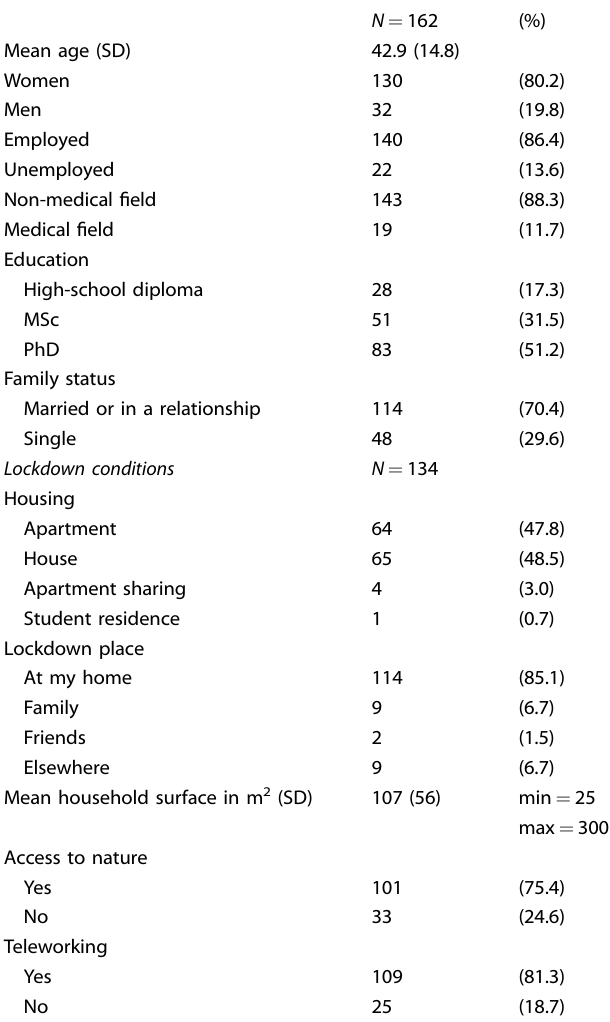
Table 1. Sociodemographic characteristics and lockdown conditions of